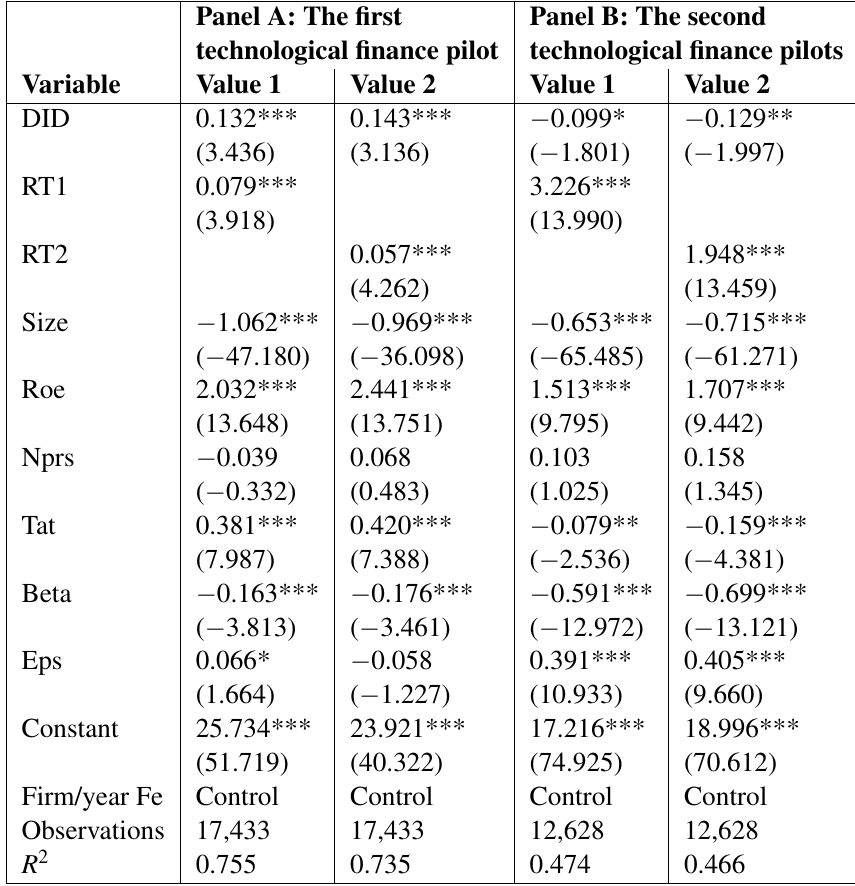
Table 6 The robustness test